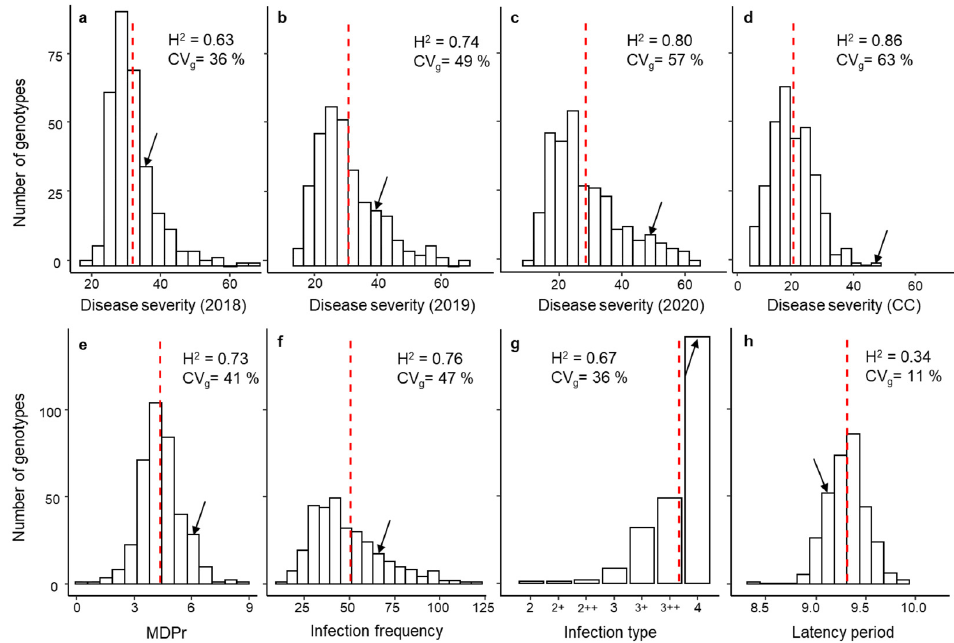
Figure 1. Phenotypic variation in rust response adjusted means (BLUPs) among 320 pea accessions after infection with U. pisi. ( a – d ) show the DS plants under field conditions during 2018, 2019, and 2020 seasons and DS seedlings under controlled conditions (CC), respectively. ( e – h ) show seedlings under CC, the monocyclic disease progress rate (MDPr), infection frequency (IF), infection type (IT), and latency period (LP50), respectively. Genotypic coefficient of variation (CV g ) and heritability (H 2 ) are also shown. Dashed red lines and black arrows indicate the overall mean and where the susceptible control Messire is located, respectively.